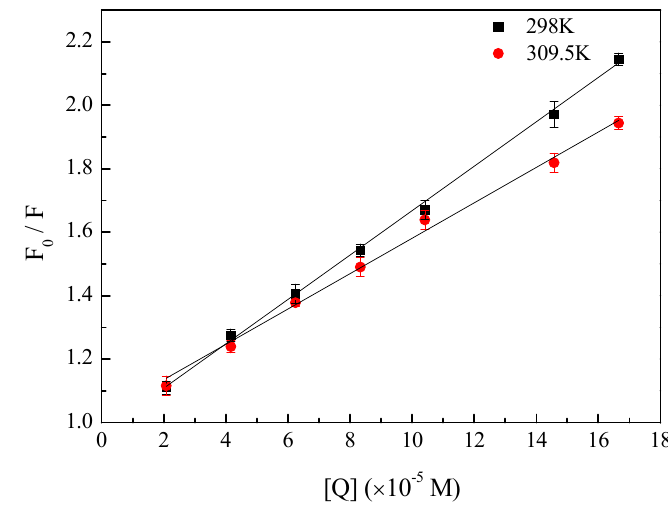
Figure 2. Stern-Volmer plots for the quenching of HSA by BZF.